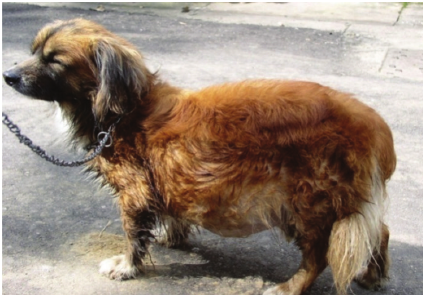
Figure 15: 4-year-old male mixed-breed dog with chronic hepatitis manifesting severe abdominal enlargement (ascites) during physical